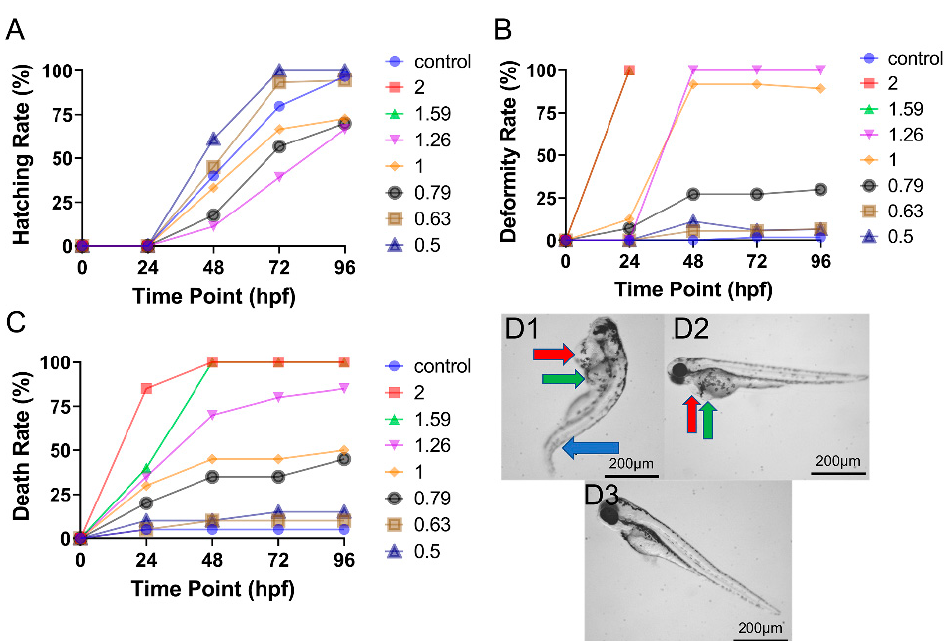
Figure 1. Concentration- and time-dependent effects of CAR on zebrafish embryo development (n = 60). ( A ) Time–response curves for hatching rate at all tested doses. ( B ) Time–response curves for deformity rate at all tested doses. ( C ) Time– response curves for death rate at all tested doses. ( D ) Typical deformities induced by ( D1 ) 1.26 mg/L, ( D2 ) 1.00 mg/L, and ( D3 ) 0.50 mg/L CAR at 96 hpf. Red arrows demarcate areas of pericardial oedema, green arrows demarcate regions of yolk sac oedema, and blue arrows show regions of spinal